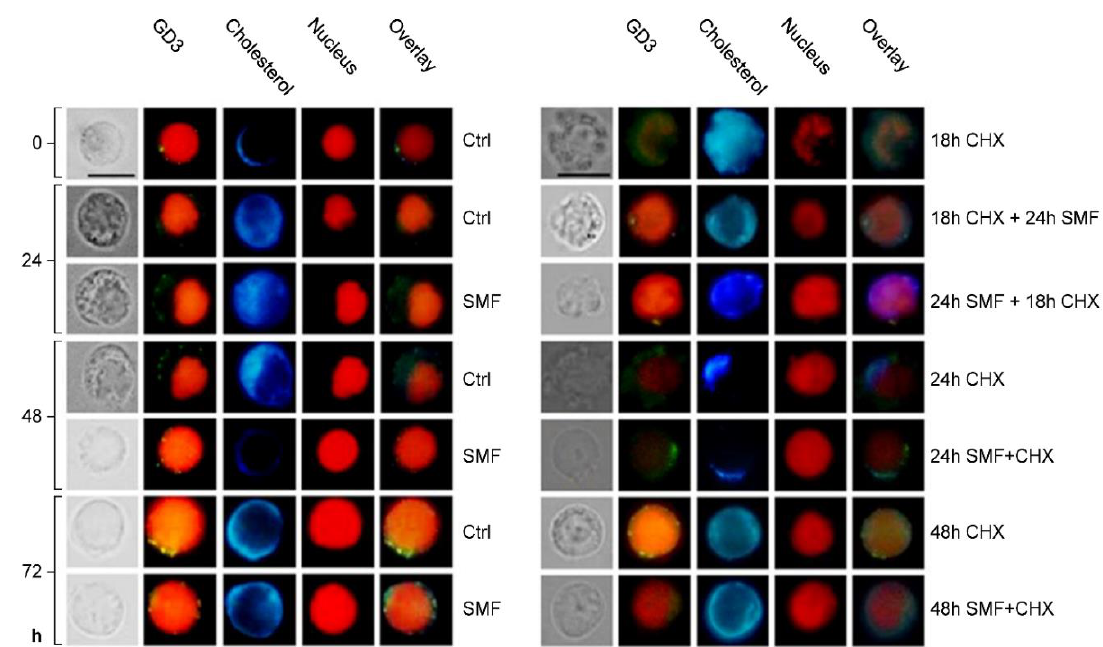
Figure 3. Triple-fluorescence staining of GD3, cholesterol and nucleus. LM micrographs of PBLs following different treatments and labeled with anti-GD3 (GD3, green); filipin (cholesterol, blue) or propidium iodide (DNA, red) taken with a fluorescence LM Eclipse 80i equipped with an illuminator Hg-C HGFIE of 130 W and DXM 1200F digital camera (Nikon), by setting a bright-field or a green (GD3)/blue (cholesterol)/red (double-stranded DNA) filter. Abbreviations: Ctrl = control PBLs, SMF = PBLs exposed to 6-mT SMF, CHX = PBLs treated with 10-mM CHX, SMF+CHX = PBLs exposed to SMF and treated simultaneously with CHX, 18-h CHX + 24-h SMF = PBLs exposed for 24 h to 6-mT SMF following treatment with CHX (10 mM) for 18 h, 24-h SMF + 18-h CHX = PBLs treated with CHX (10 mM) for 18 h following exposure for 24 h to 6-mT SMF, h = hours and bars = 10 μm.